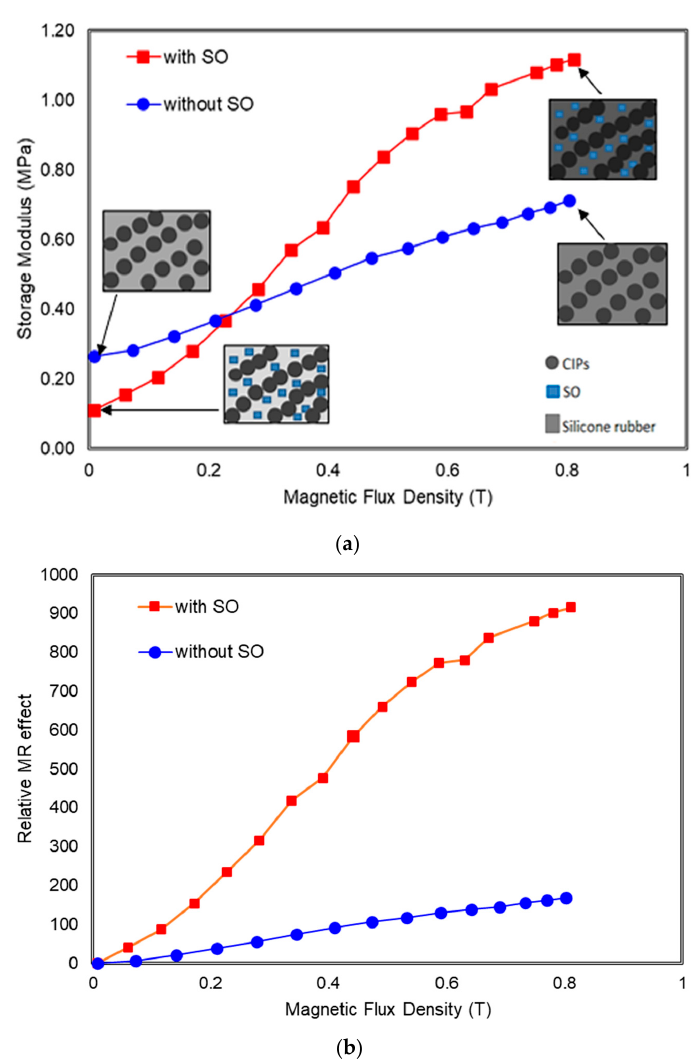
Figure 11. MRE with orientation mold of 45° with and without SO ( a ) Storage modulus and ( b ) Relative MR effect as a function of magnetic swept . Table 4. The initial storage modulus (G 0 ), the magnetic ‐ induce modulus ( ∆ G) and the MR effect of MRE 45° with and without plasticizer. Sample